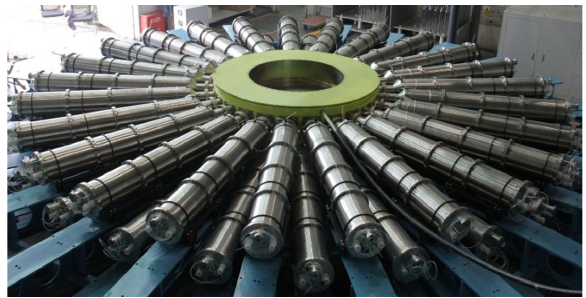
FIG. 18. Reset circuit topology and schematic diagram of the stage. FIG. 19. The installed hybrid mode LTD